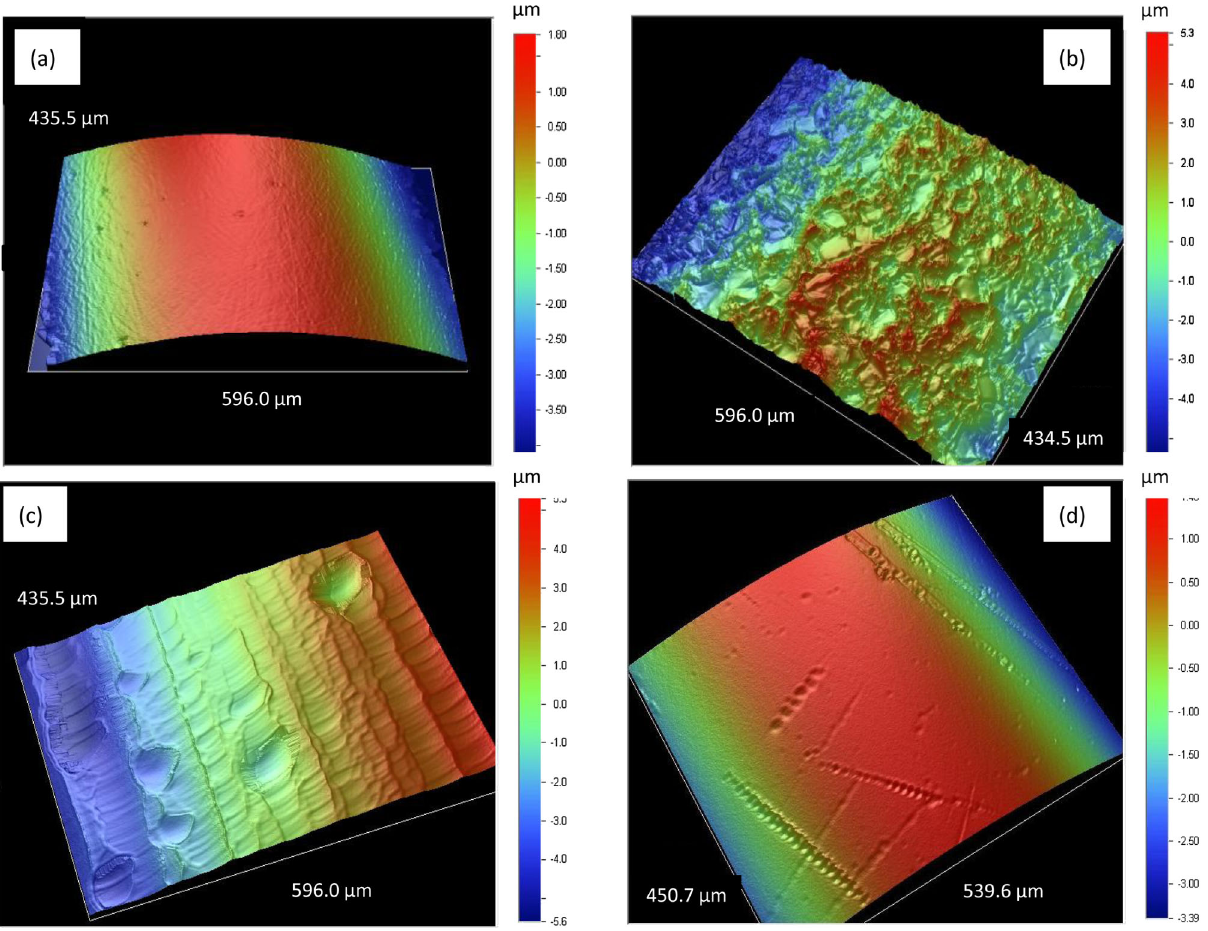
FIG. 6. Optical profilometer images of (a) DPP 304 stainless steel, (b) fine-grain niobium, (c) large-grain niobium, and (d) single- crystal niobium. The span of each image is very nearly the same, approximately 450 (cid:3) m (cid:5) 600 (cid:3) m